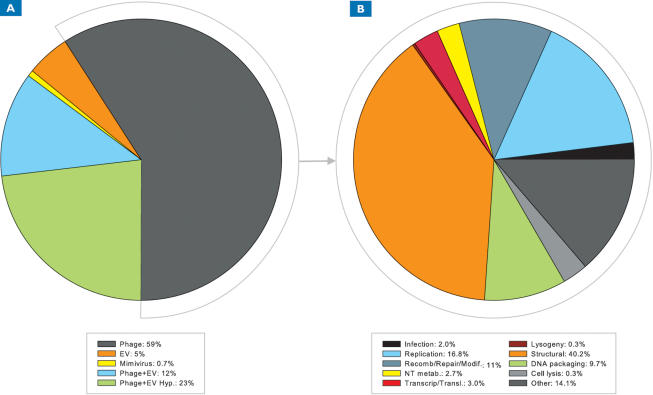
Breakdown of clustered GOS viral sequences by virus type (A) and functional classification of clustered bacteriophage sequences (B).EV stands for eukaryotic virus and Hyp stands for hypothetical.